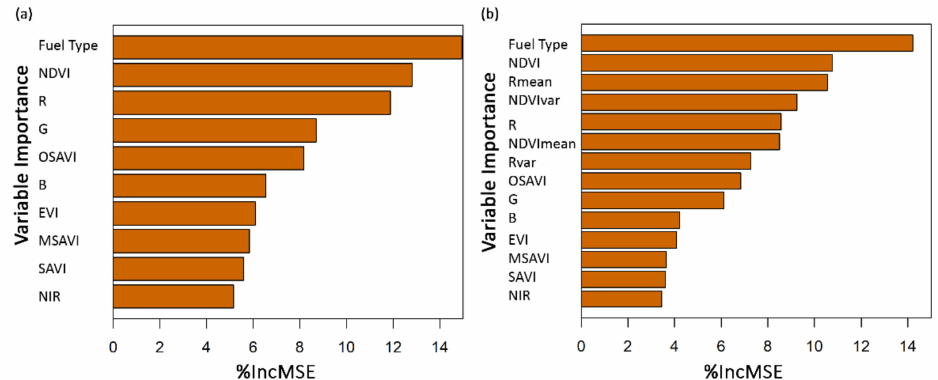
Figure 4. The variable importance for biomass model based on high spatial resolution images. ( a ) the variable importance for the biomass model without texture indices as explanatory variables based on the high spatial resolution images, ( b ) the variable importance for the model with texture indices as explanatory variables based on the high spatial resolution images. The X -axis indicates the percent increase in Mean Square Error (%IncMSE). B, G, R, and NIR represent the spectral curves for blue, green, red, and near-infrared bands of the high-resolution imagery, respectively. Rmean, Rvar, NDVImean, and NDVIvar represent the mean and variance of the texture calculations on the red band and NDVI,